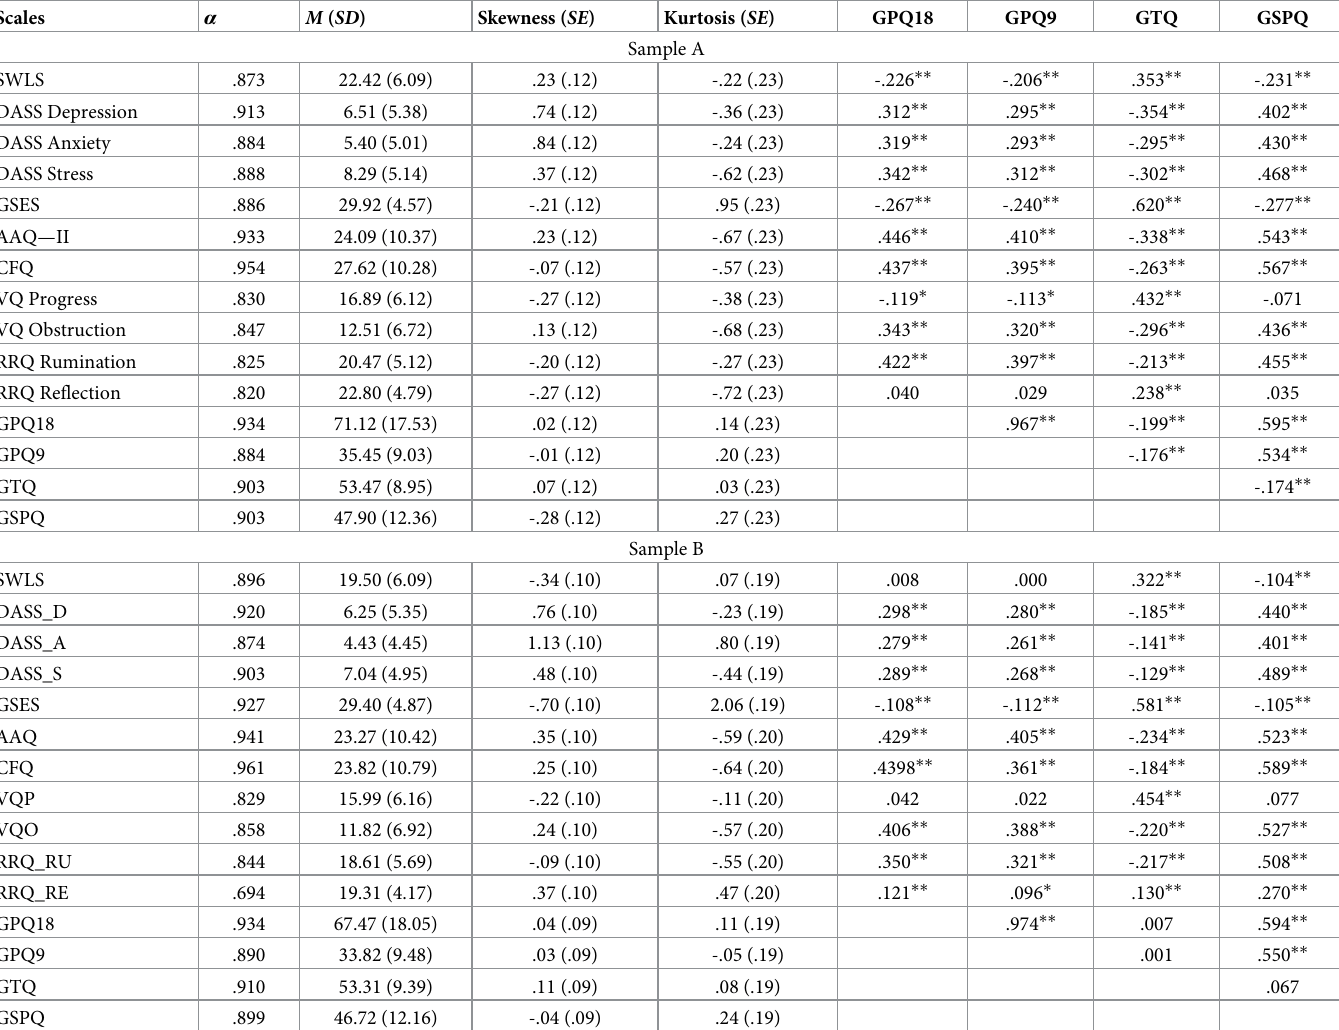
Table 3. Descriptive statistics and correlations between GPQ18, GPQ9, GTQ, GSPQ and other measures’ scales in both samples.